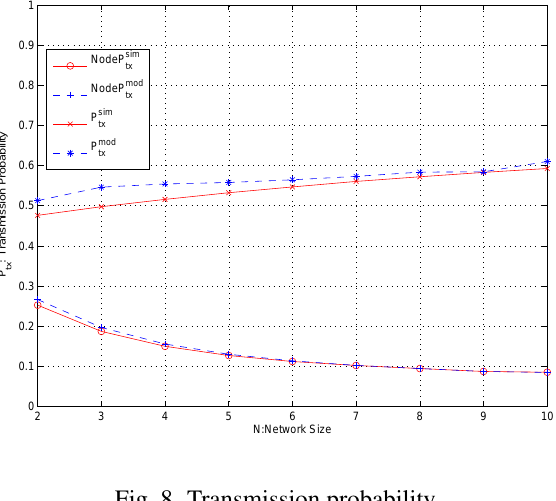
Fig. 8. Transmission probability The relation between the per-node collision probability and the the probability that one or more nodes are transmitting is not simple, ie. they are not in a linear relationship. Fig. 9 has given the results. We have contrasted the average collision probabil- ities of the node and the network. The simulation always have a higher collision probability than the network despite looking at per-node or per-network.